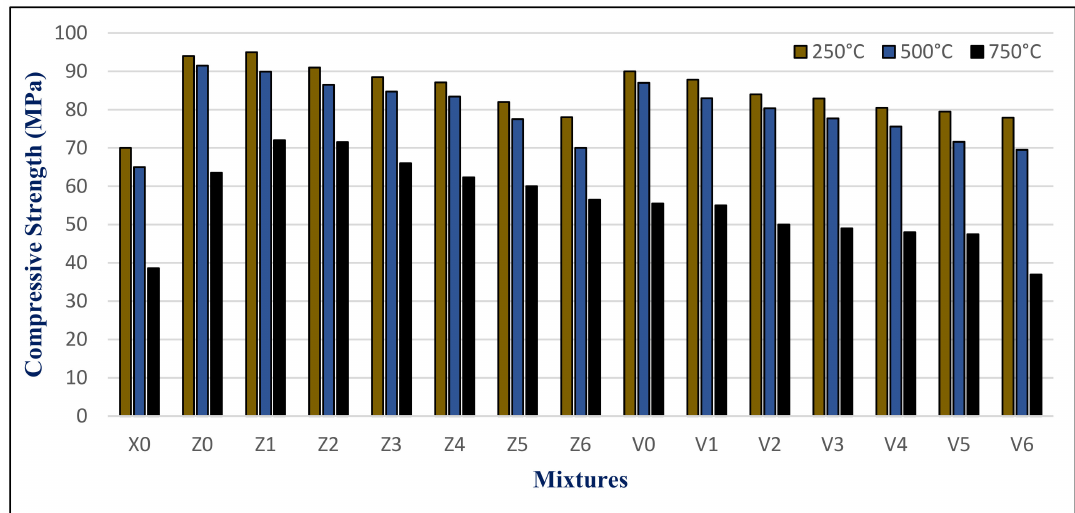
Figure 21. Groups Z and V strength results after exposure to elevated temperatures at 28 days.